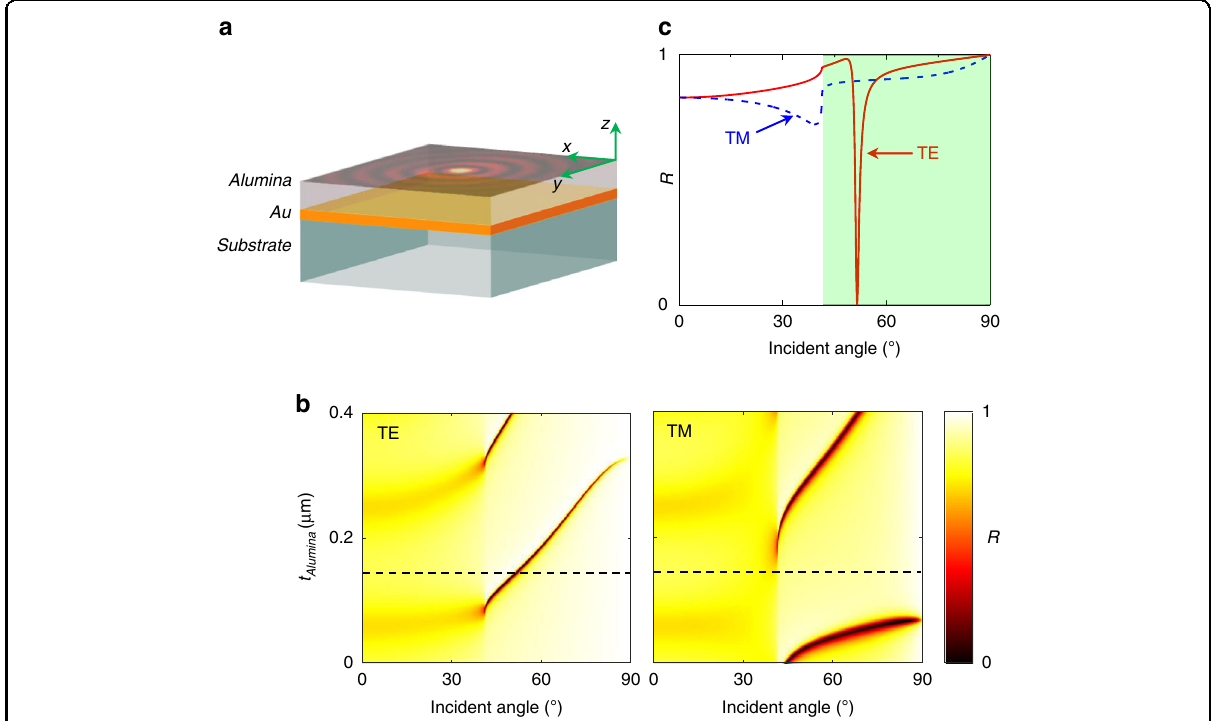
Fig. 3 Designed metal-dielectric waveguide. a Schematic showing a thin gold fi lm sandwiched by an alumina layer and a silica substrate, b contour maps of the re fl ectivity ( R ) of the metal-dielectric waveguide structure calculated using transfer matrix theory 57,58 for both the TE and TM modes, c re fl ectivity curves when the thickness of alumina layer ( t Alumina ) equals 145 nm (corresponding to the black dashed lines in b ). Only the TE mode exists in the metal-dielectric waveguide. The thickness of the gold fi lm was fi xed at 40 nm in the